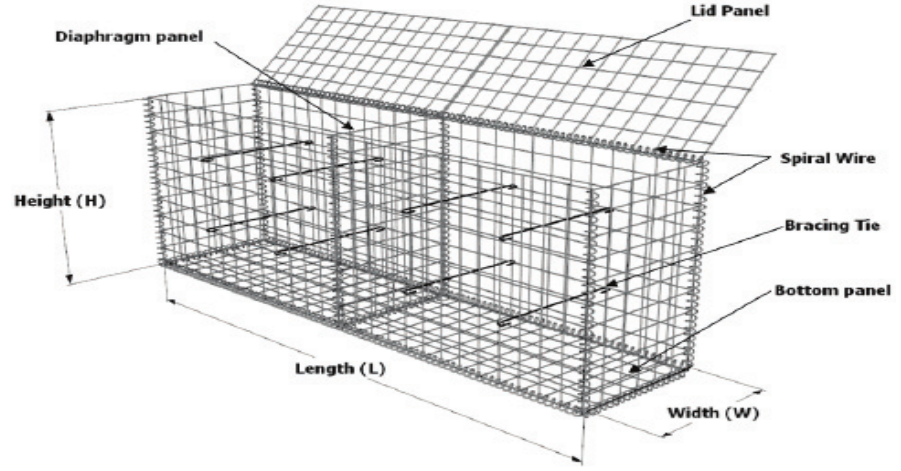
Fig. 2. Schematic image a welded mesh gabion basket [8]